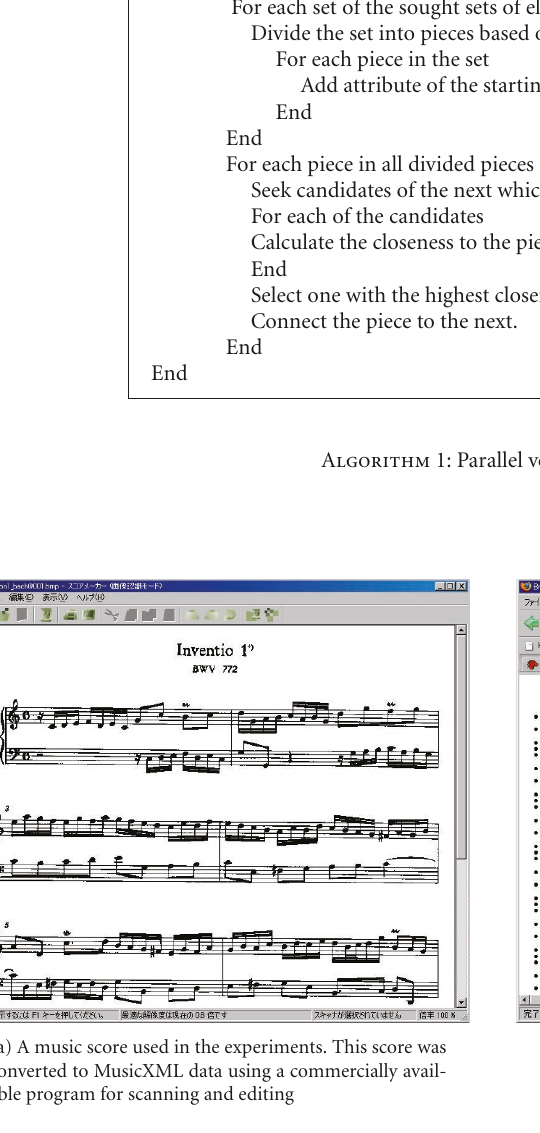
Figure 10: A sample of the resultant Braille music